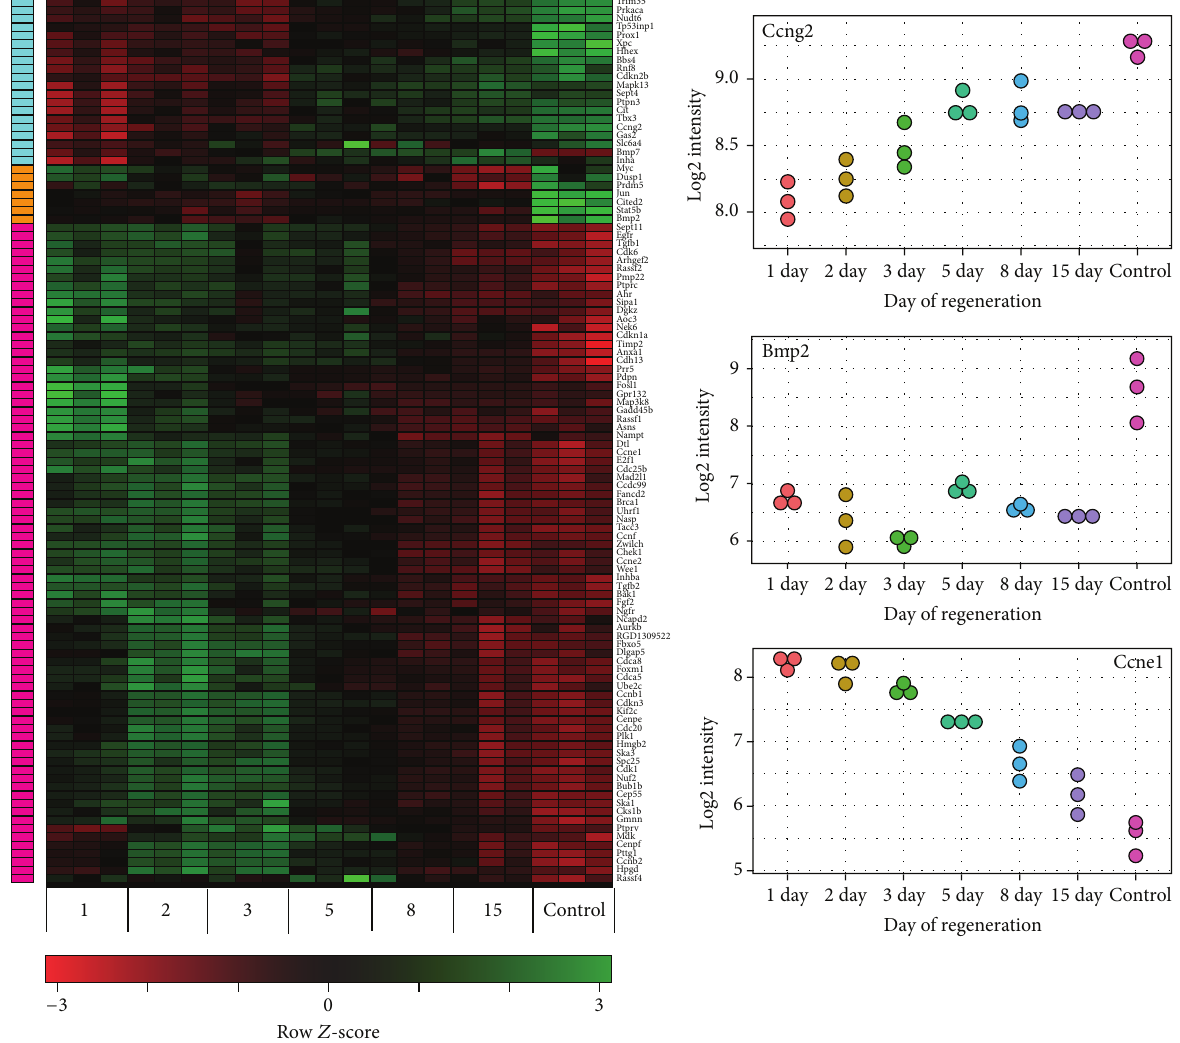
Figure 4: Heat map representation of microarray analysis for the 106 transcripts of genes involved in cell cycle, with the highest differential expression in regenerating adrenals (versus control glands), independent of the day of change (days 1, 2, 3, 5, 8, and 15 of experiment). Signal intensity acquired from microarray analysis is represented by colors (see color key). Green color—increase of expression, red—decrease. Studied genes were clustered by means of hierarchical clustering algorithm. The following clusters were obtained: 20 genes with the highest expression between days 5 and 15 of regeneration (pink); 7 genes with the highest expression in control glands (orange); 79 genes with the highest expression at days 1 to 5 of experiment (blue). C—control animals. Dot-plot graphs present profile expression of 3 genes (Ccng2, Bmp2, and Ccne1) which are representatives for each heat map